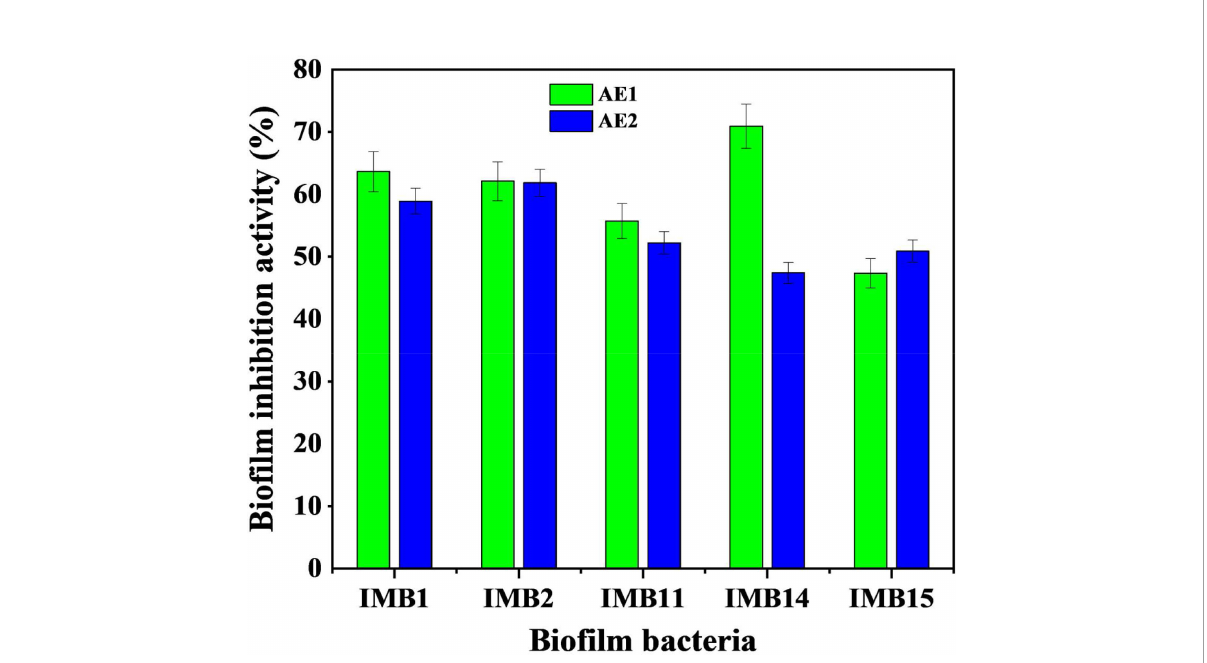
FIGURE 3 Bio fi lm inhibition activity of crude extracts from Alcanivorax sp. AA8 bacteria against fi ve bio fi lm bacteria. Each data point represents an average of eight replicates and SD. Key: IMB1, Pseudoalteromonas sp. IMB1 (ON003955); IMB2, Halomonas sp. IMB2 (ON415519); IMB11, Vibrio alginolyticus IMB11 (ON003958); IMB14, Pseudoalteromonas gelatinilytica IMB14 (ON003961); IMB15, Pseudoalteromonas gelatinilytica IMB15